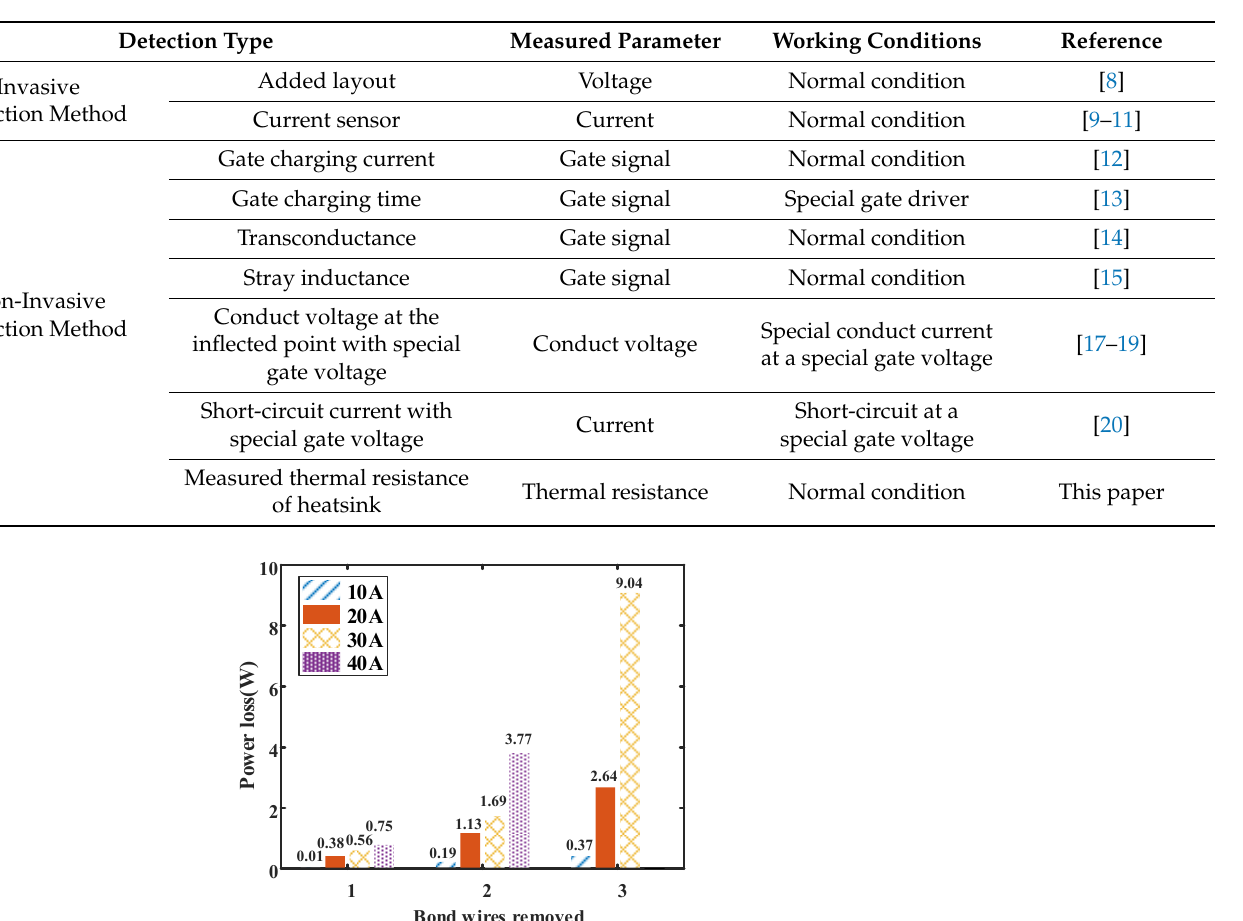
Table 4. Comparisons of bond wire fault detection.